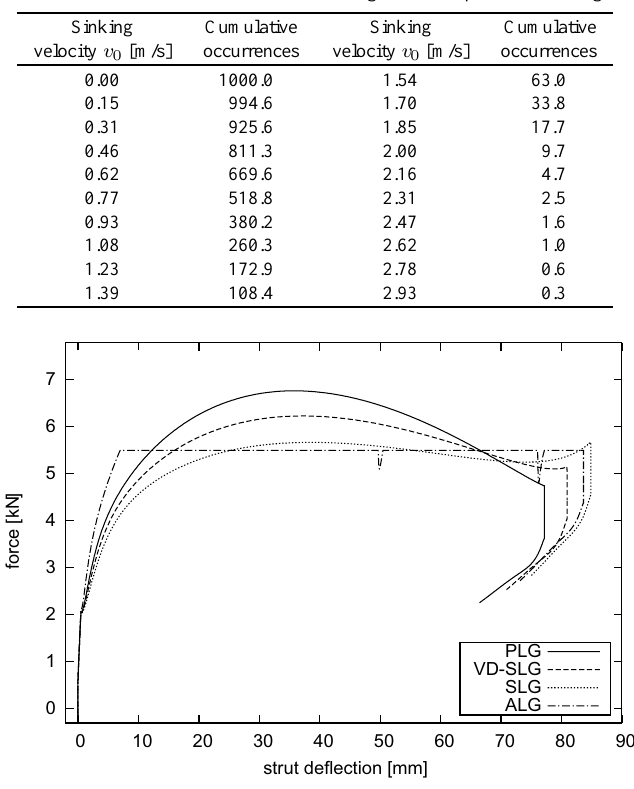
Fig. 14. Strut force versus deflection in PLG, VD-SLG, SLG and ALG for m = 350 kg and v 0 = 1 . 5 m / s